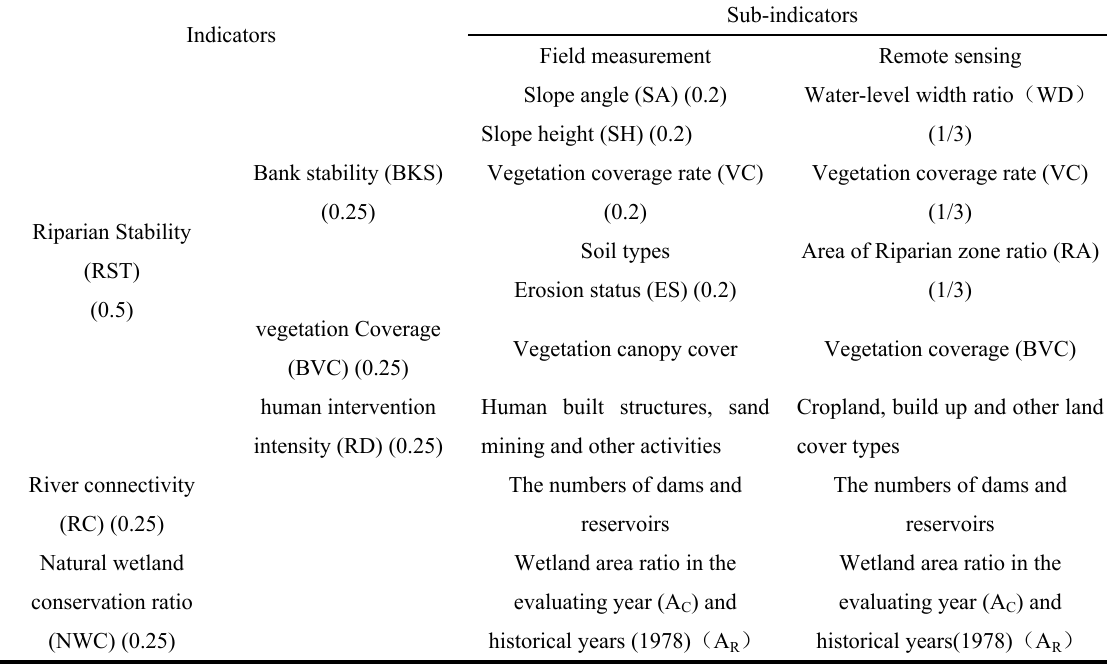
Table 1. The evaluating indicators and weights of